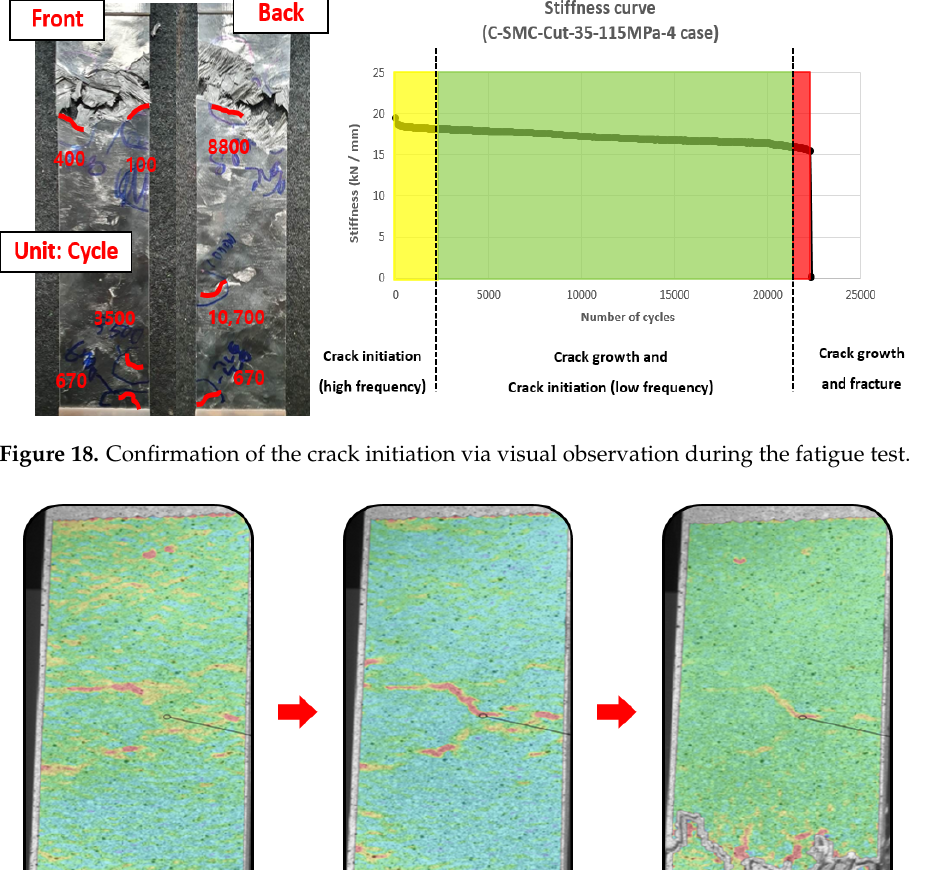
Figure 18. Confirmation of the crack initiation via visual observation during the fatigue test.